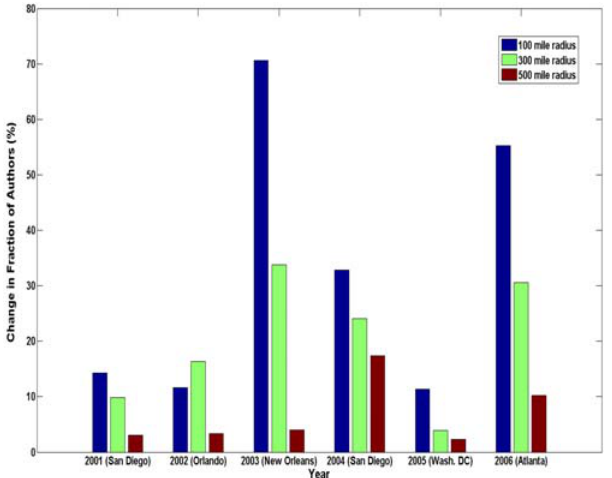
Figure 2. The effect of meeting location on nearby author participation. Percentage change in proportion of overall author contributions that were from the region surrounding the meeting location (100, 300, or 500 mile radius) relative to years when the meeting was elsewhere (for all meetings, 2001–2006).